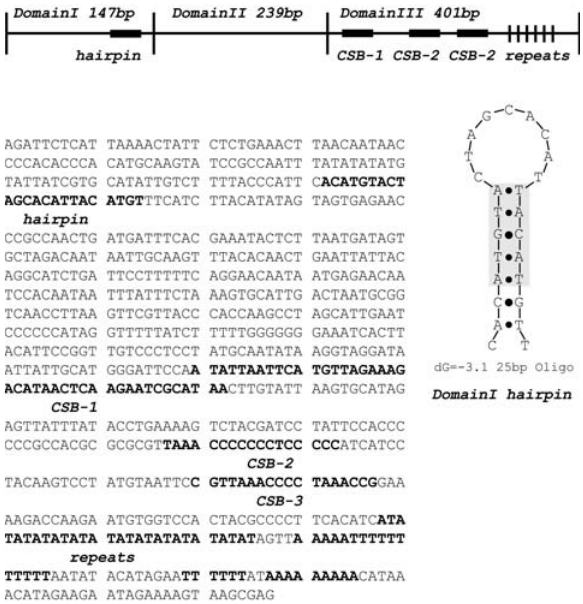
Figure 2 - Schematic map characterizing of the control region of Arapai- ma gigas . Indicated are the three domains, a potentially regulatory hairpin in domain 1, the three conserved sequence blocks in domain 3, and a series of repeats in domain 3.